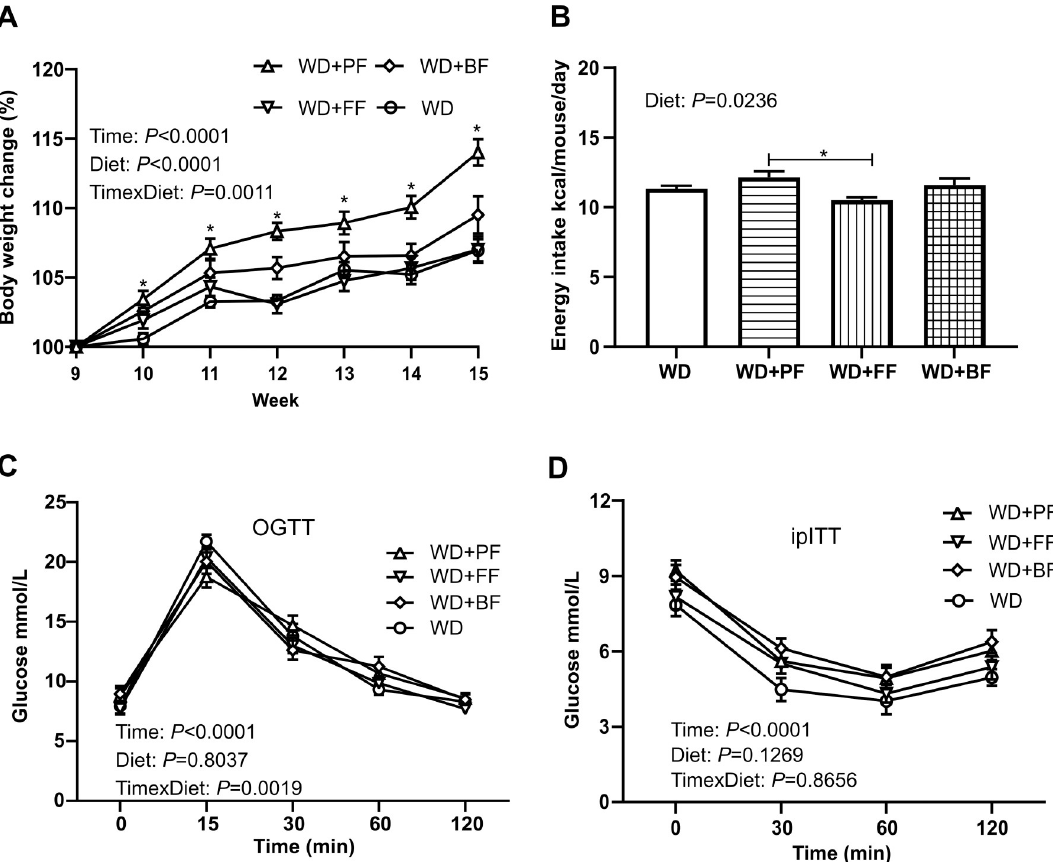
Fig 2. Bodyweight development, energy intake and glucose regulation prior to DSS treatment in WD fed C57BL/6JRj mice. Bodyweight development (2A) during the feeding trial with modified WDs (n = 12 except WD-fed mice, n = 24). Estimated energy intake (2B) per mouse per day from week 9 to week 15. OGTT (2C ) after 4 hours of fasting at week 3 (n = 12). IpITT (2D) after 6 hours of fasting at week 4 (n = 12). � means significantly different ( P < 0.05). Values are means ± SEM. For panels A, B, D mixed-effect model whereas for panel C 2-way ANOVA with repeated measures was